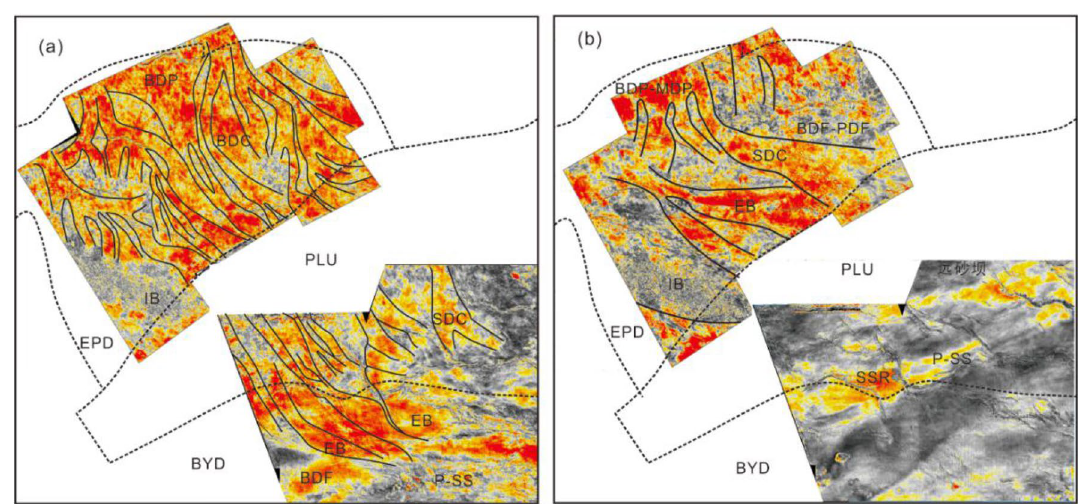
Figure 6. Depositional interpretation of the root mean square amplitude slice of the Braided river delta systems in the Highstand systems tract of S1 ( a ) and transitional characteristics of the Braided river delta and Meandering river delta systems in the Highstand systems tract of S2 ( b ). The Braided river delta systems are characterized by large scale straight distributary channels in the delta plain, whereas the transitional delta systems exhibit small scale or no delta plain deposits and several curved subaqueous distributary channels in the delta